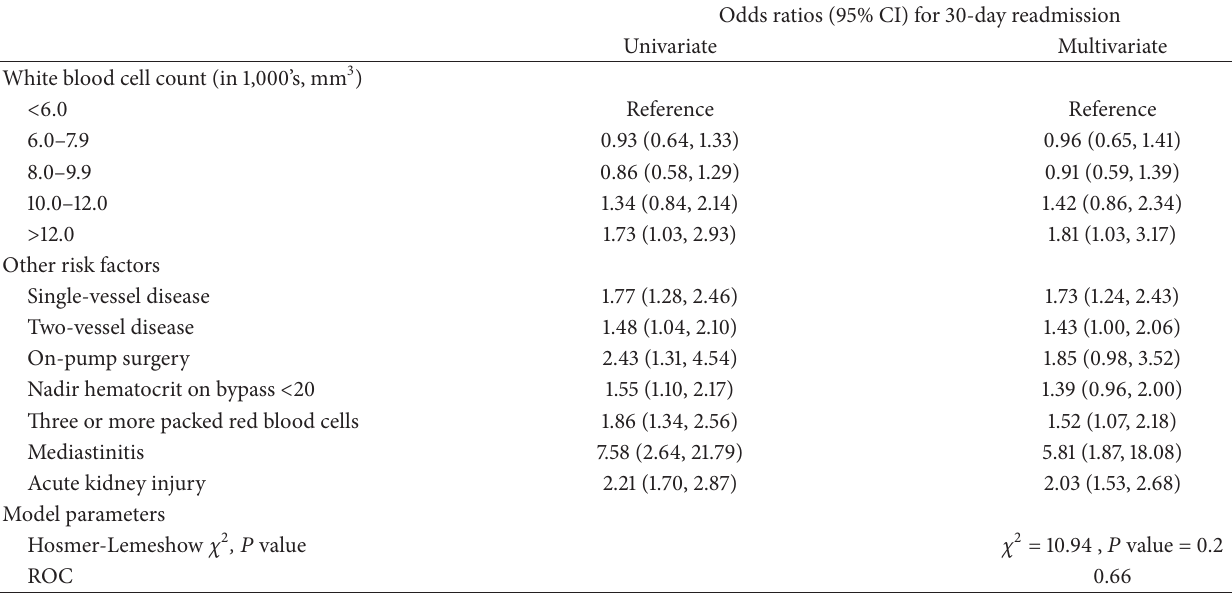
Table 3: Univariate and multivariate regression anaylsis for 30-day readmission.